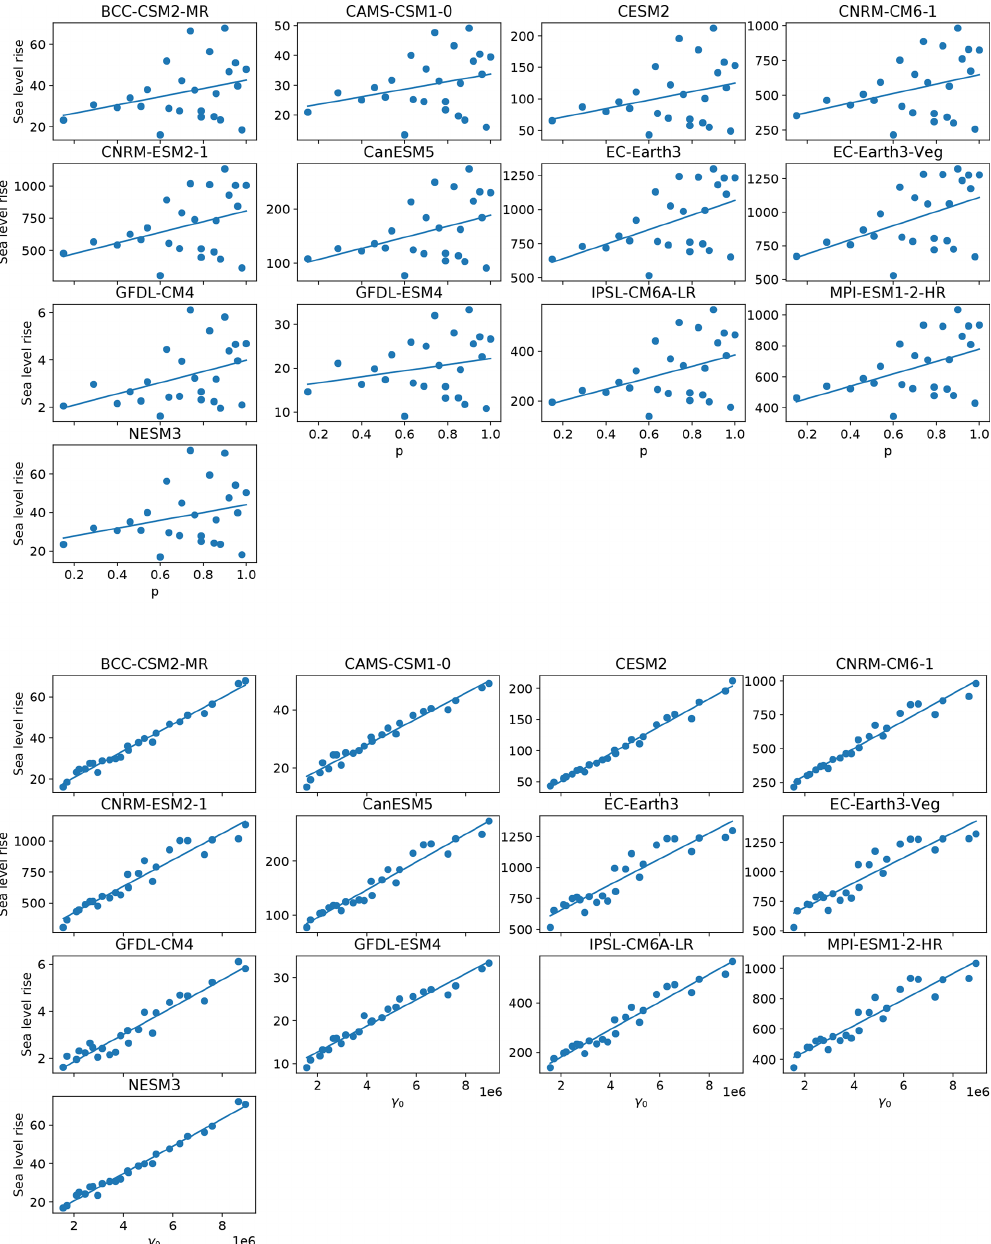
Figure A6. SLR as a function of p and γ 0 in the Ross